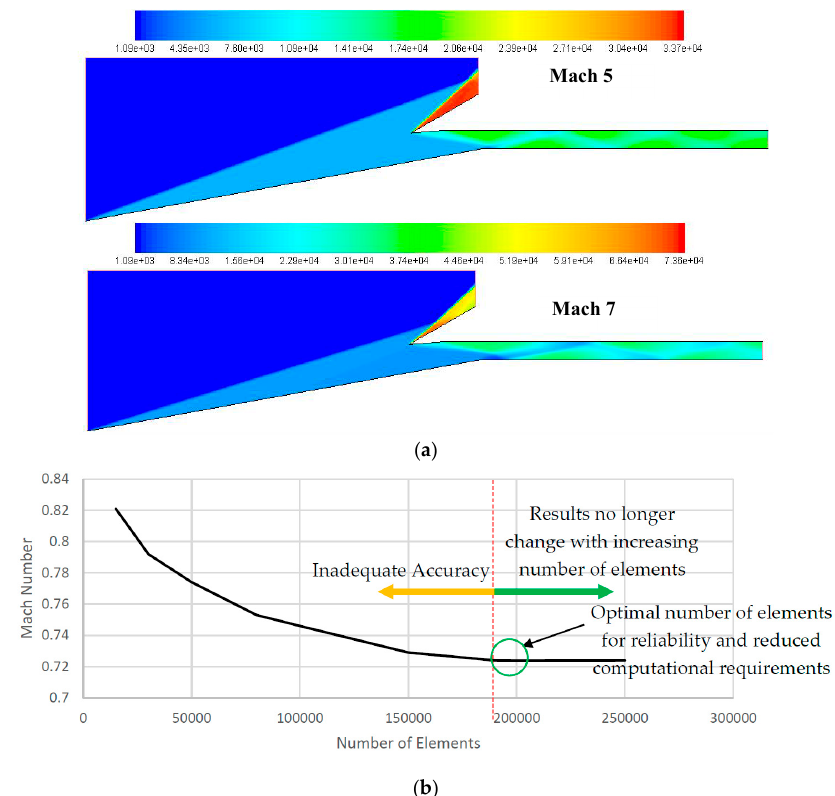
Figure 12. ( a ) Static pressure contour obtained in ANSYS Fluent with setup and ( b ) grid independence associated with the CFD setup.